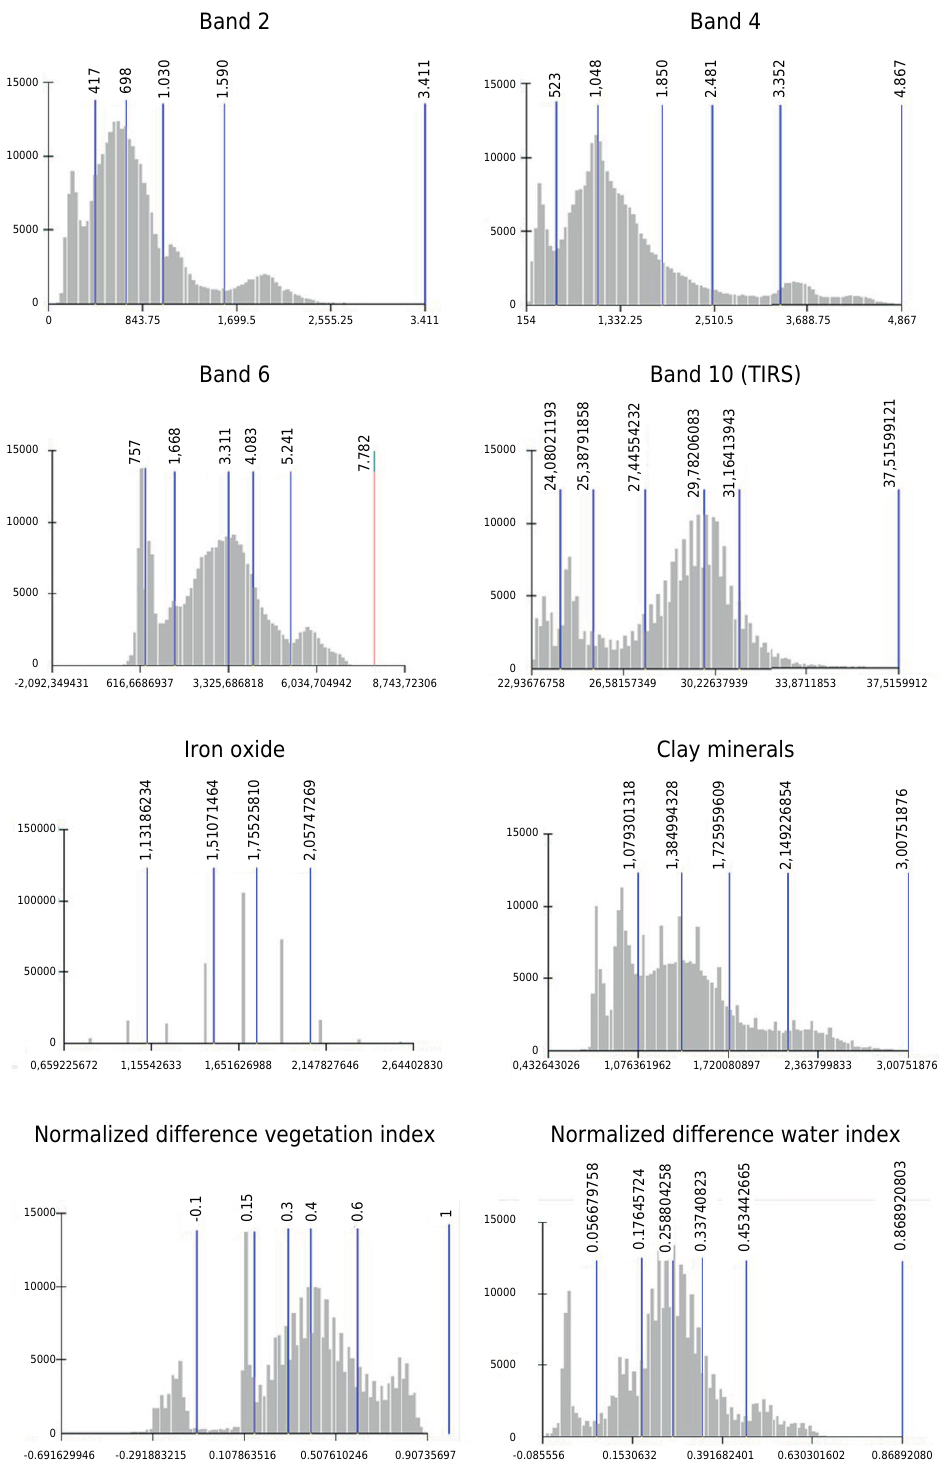
Figure 4. Frequency histogram of the spectral